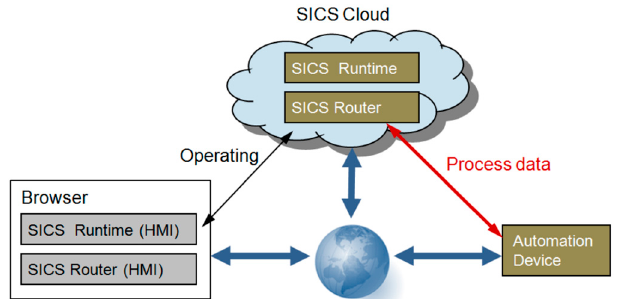
Figure 11. SICS controller in the server-based mode (SM).